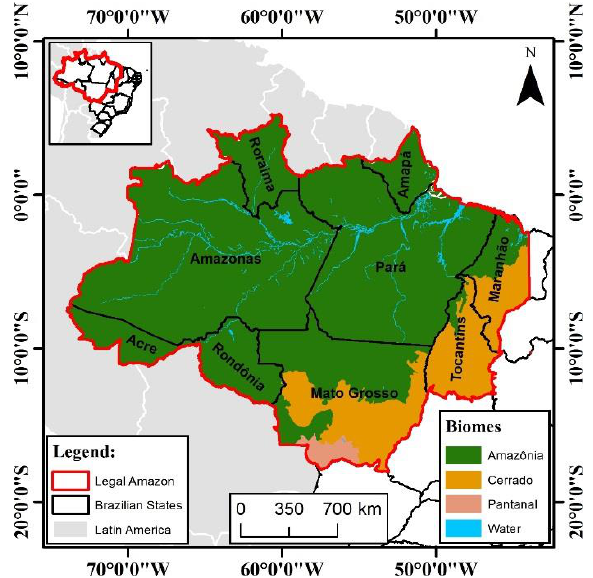
Figure 1. Location of the study area with the red line indicating the area of the Brazilian Legal Amazon, the black line are the political boundaries of Amazonian states and colours represent the different Brazilian biomes proposed by the Brazilian Institute of Geography and Statistics (IBGE) [35].